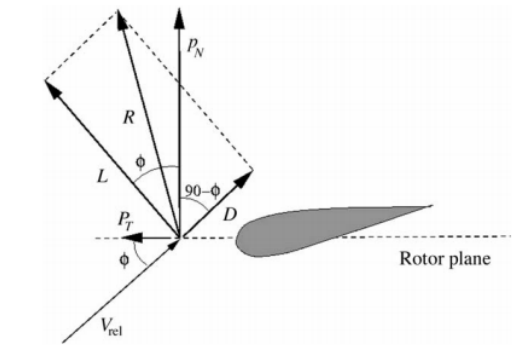
Figure 8. Loads on a blade airfoil